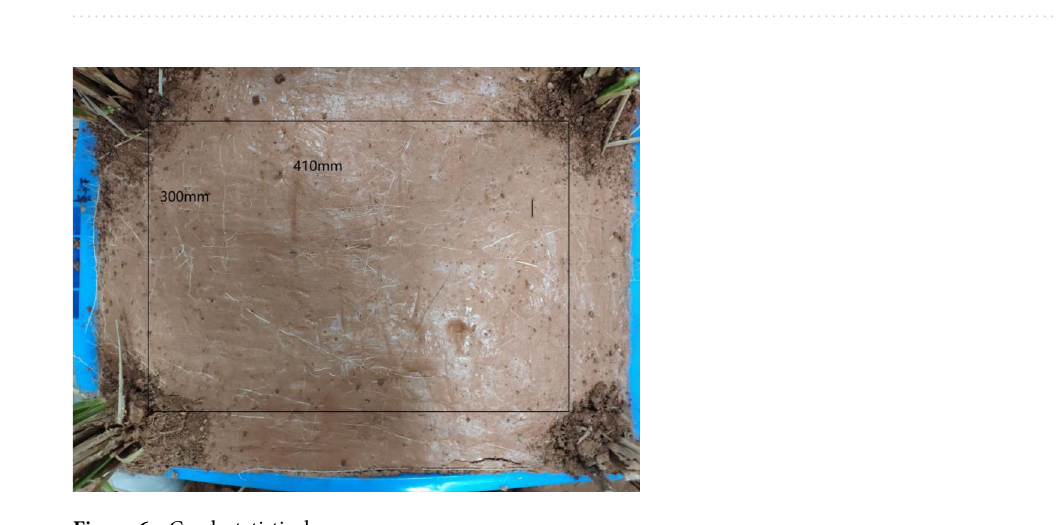
Figure 6. Crack statistical